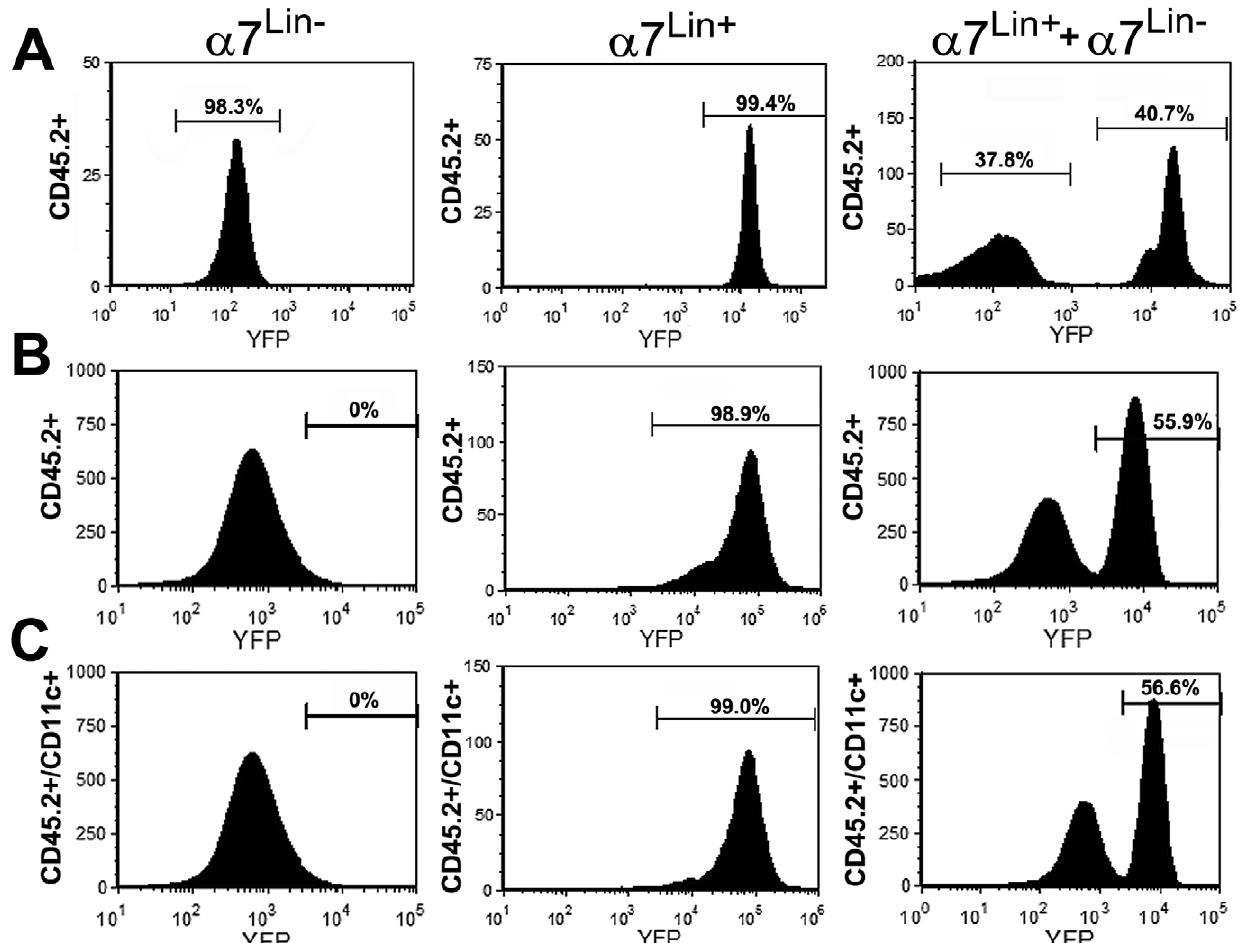
Figure 6. Mice Reconstituted with bone marrow cells that were either a 7 lin- , a 7 lin + or both, have alveolar macrophages of donor lineage. Bone marrow was isolated from a 7 Cre:YFP and sorted (see Methods) into a 7 lin + (YFP + ) or a 7 lin– (YFP - ). In the top panel (A) we show the re- analysis of the sorted cells used to re-populate the recipient mice (CD45.1 + ). These populations were also mixed in even numbers (50:50) and this mixture injected into recipient mice. Recipient mice were sacrificed at 10 weeks (B) and the a 7 lin phenotype measured from lung cells collected subsequent to lavage. Lung lavage cells from mice receiving a 7 lin– cells were YFP - , CD45.2 + and CD11c + (C) indicating that these cells were AM that differentiated from the donor bone marrow. AM from recipients that were transplanted with a 7 lin + bone marrow cells were YFP + , CD45.2 + and CD11c + . Lung lavages from recipients of the a 7 lin- : a 7 lin + CD45.2 bone marrow cells had AM that were all CD45.2 positive and were present in approximately equal numbers. This experiment has been performed at least 3 times with similar results.